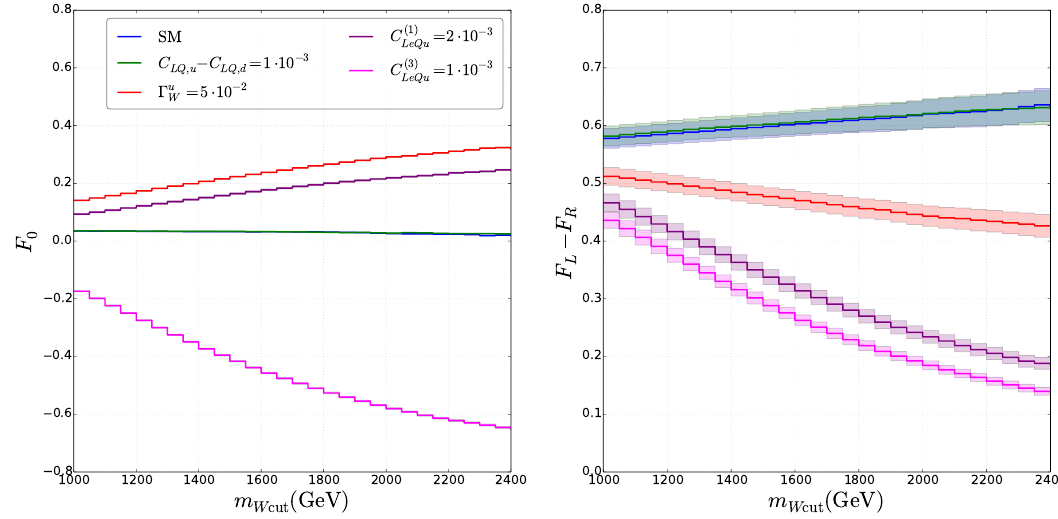
p S = 13 TeV. The shaded regions